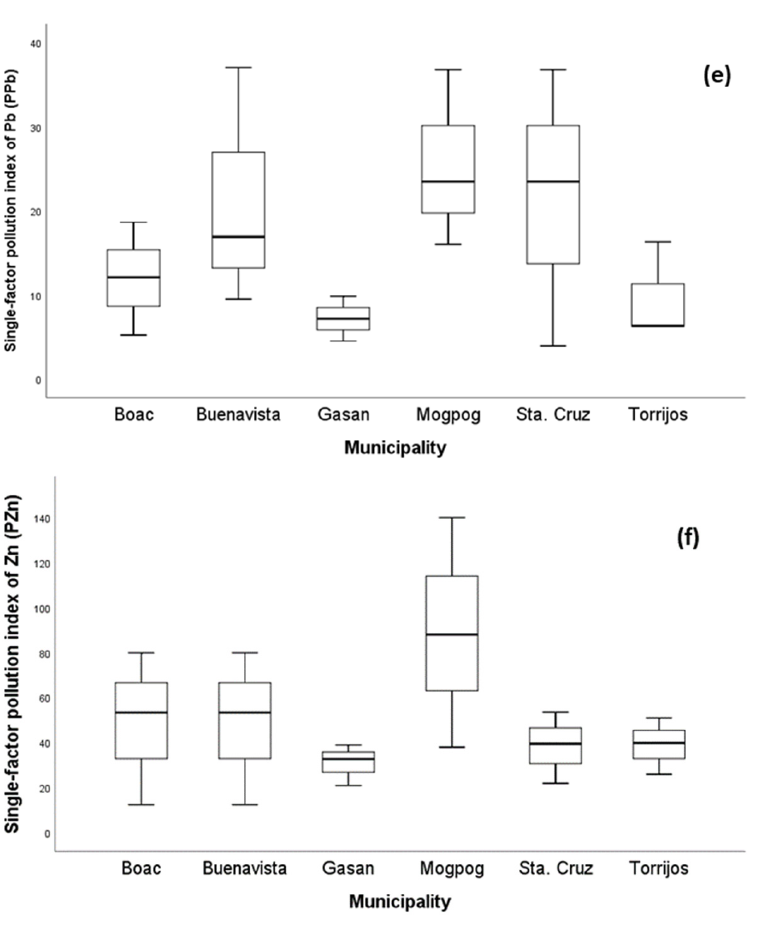
Figure 2. The single-factor pollution index ( 𝑃 (cid:3036) ) of soil per municipality of the island province. The 𝑃 (cid:3036) of ( a ) Cr, ( b ) Cu, ( c ) Mn, ( d ) Ni, ( e ) Pb, and ( f ) Zn in soil from all municipalities across the province.